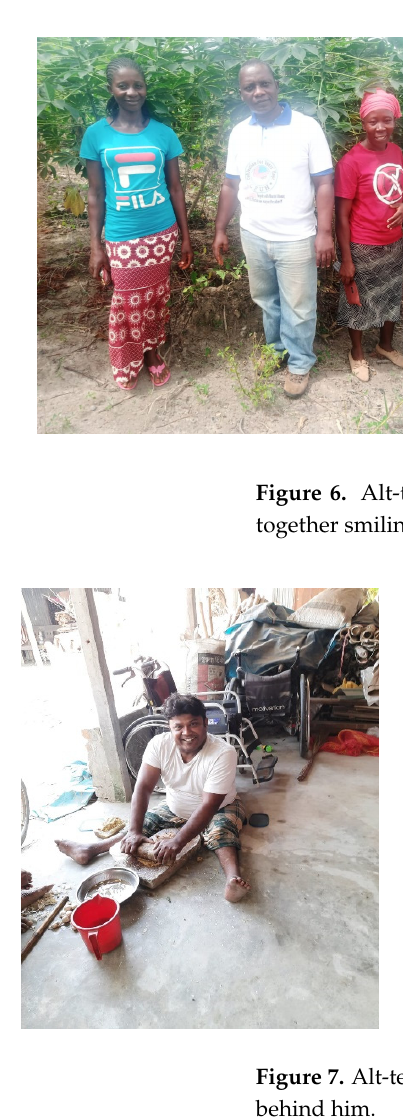
Figure 8. Alt-text: Three young men posing outdoors—two young men in wheelchairs smiling and posing with a cricket bat, and another standing behind them. 5.4. Adaptability and Technology Technology provided platforms for adaptability in communication, studying and work. However, technology was only empowering for those who had access to smart phones, particularly younger generations of higher socio-economic status who lived in cities. The wide use of technology often excluded people, particularly women living in rural areas, and older population groups who do not have access to smart phones.. Many younger co-researchers living in the cities in Liberia and Bangladesh illustrated how online platforms, such as Zoom, helped them to adapt through online learning and working from home (Figures 9 and 10). However, technology was also described as a barrier, as some co-researchers described experiencing difficulties in online learning, and missing face-to-face contact with teachers.